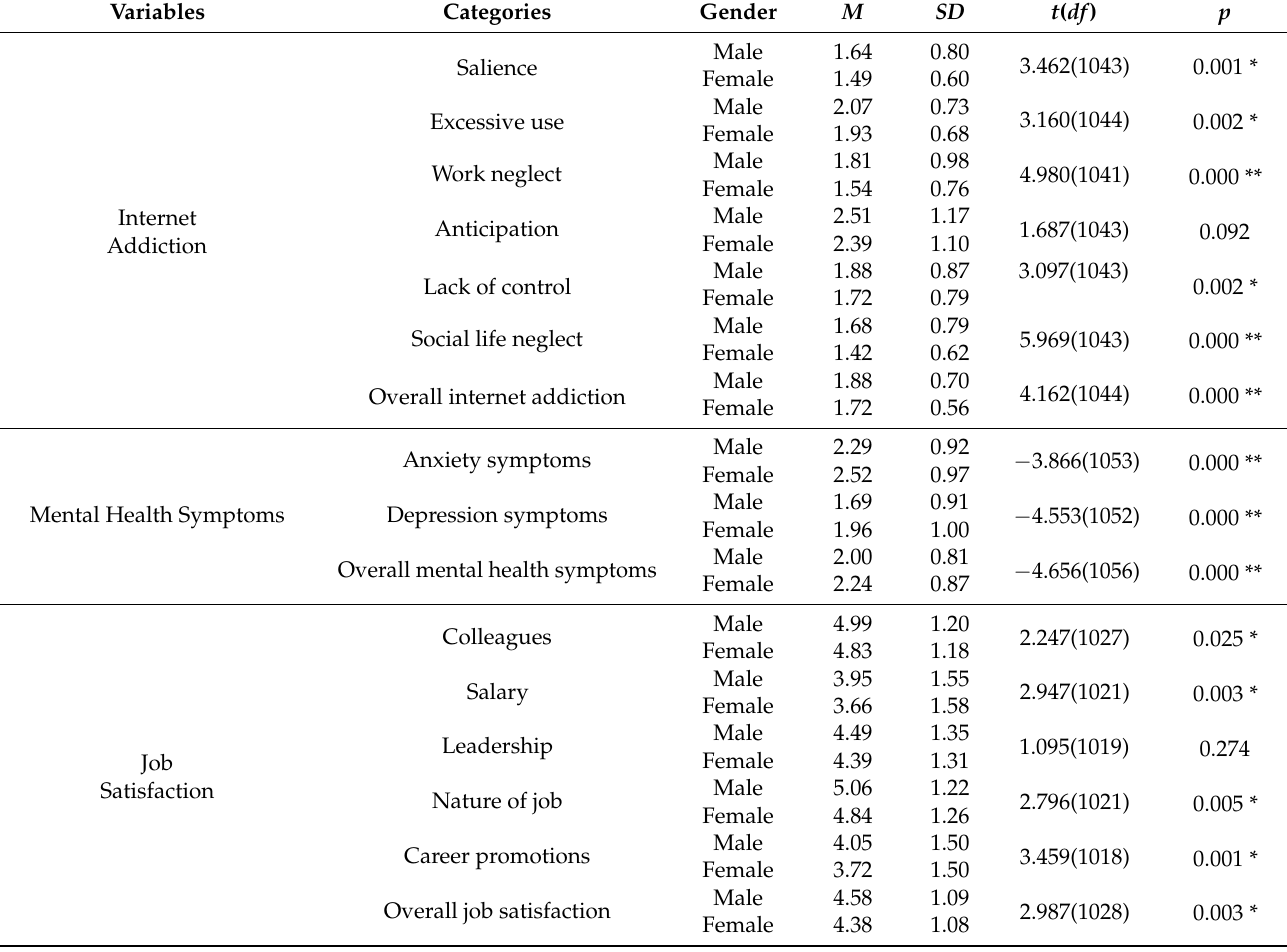
r = 0.173; p < 0.001). Table 3. Internet addiction, mental health symptoms, and job satisfaction levels between male and female participants. Variables